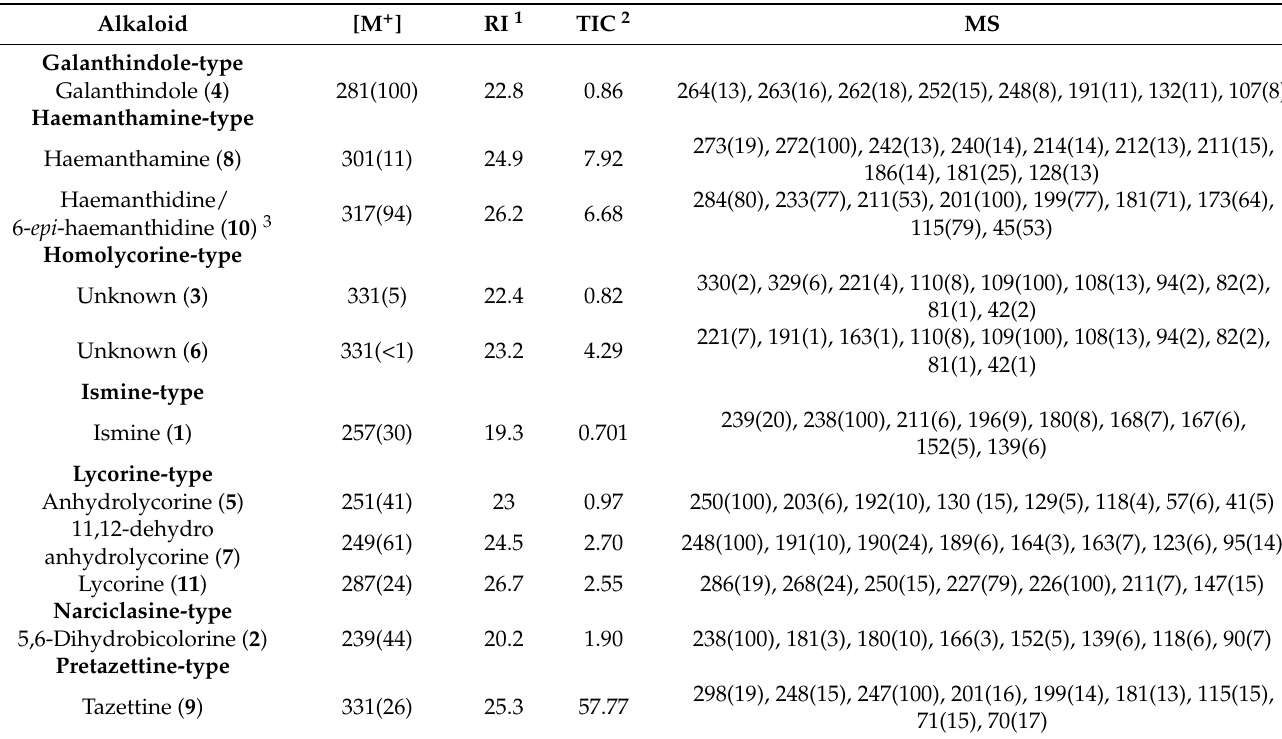
Table 1. GC-MS data for H. cardenasianus alkaloid